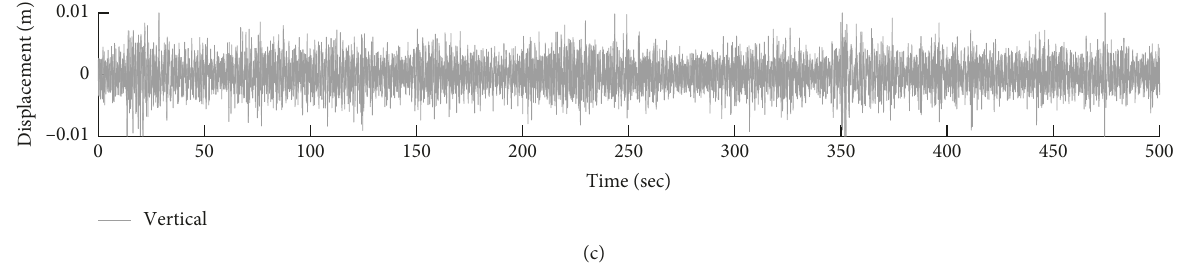
Figure 10: Dynamic displacements in three directions: (a) N-S, (b) E-W, and (c) vertical.